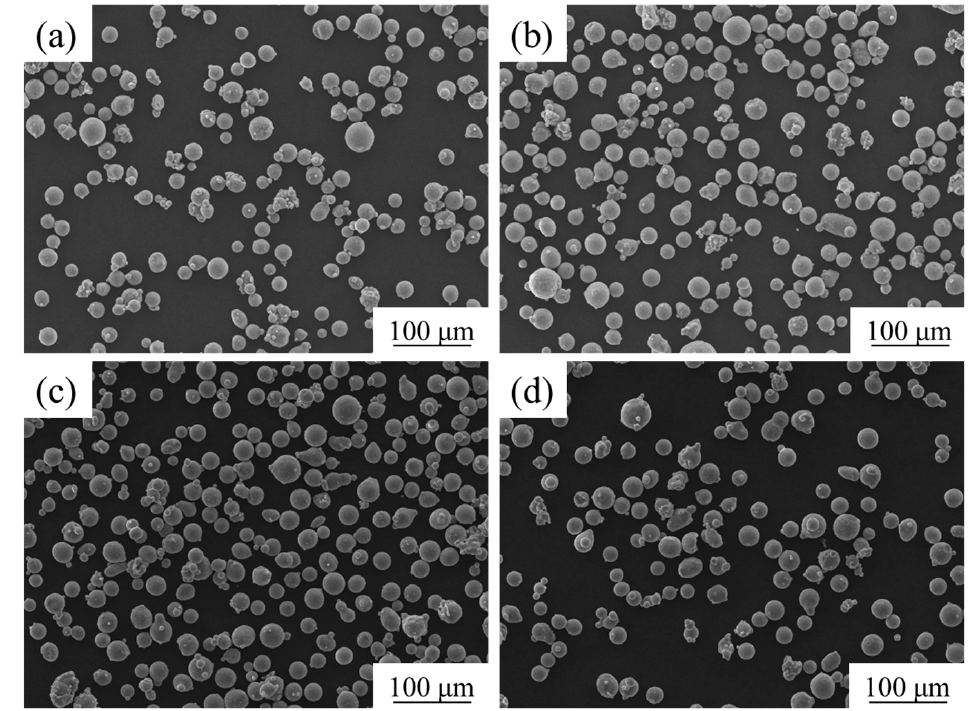
Figure 1. The morphology of Al-6.2Zn-2Mg-xSc-xZr alloys powder, ( a ) sample 1, ( b ) sample 2, ( c ) sample 3, ( d ) sample 4.